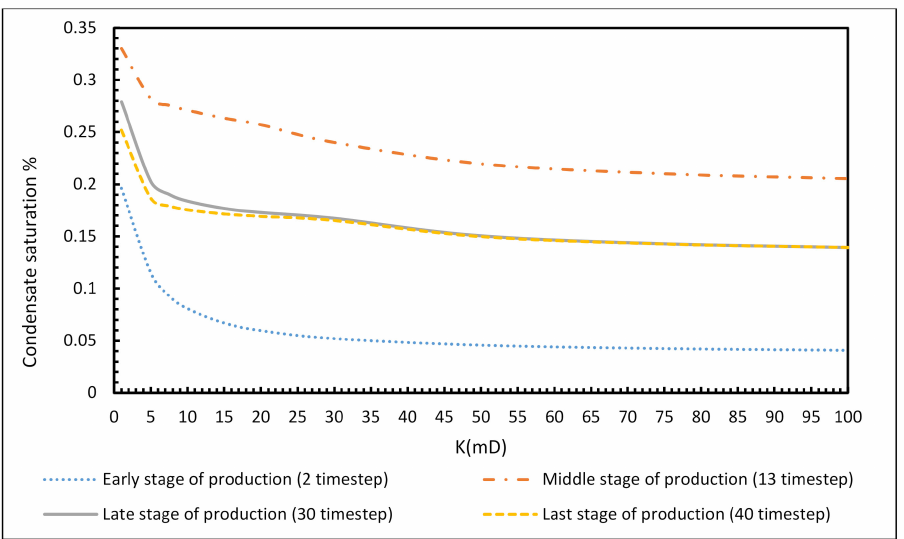
Figure 9. Condensate saturation as a function of permeability at the wellbore for di ff erent stages of production (global analysis).